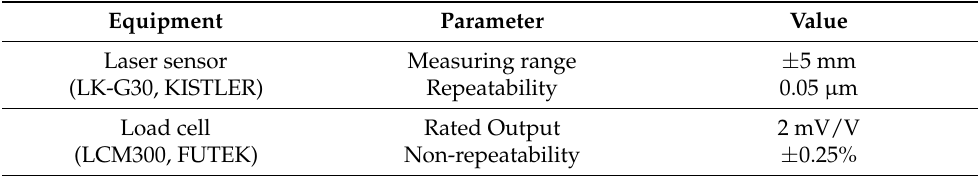
Table 2. Components of the experimental setup for measuring the attraction force.